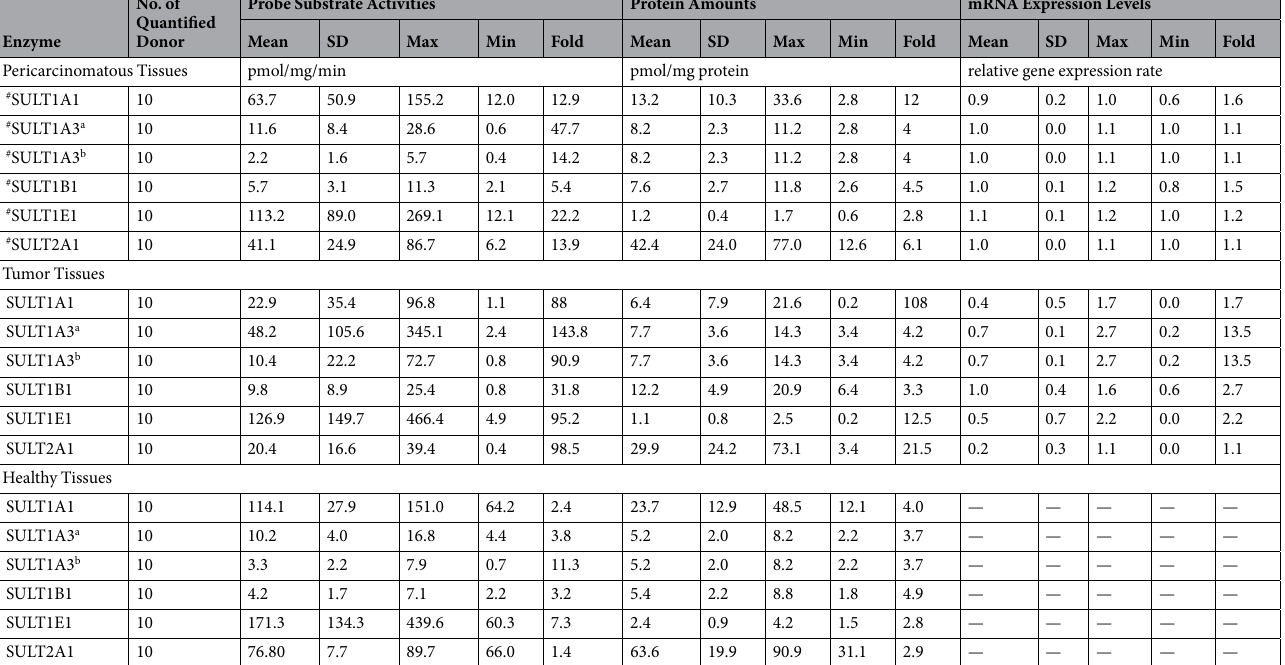
Table 3. SULTs Activities and Expression differences in Pericarcinomatous, Tumor and Healthy tissues. a